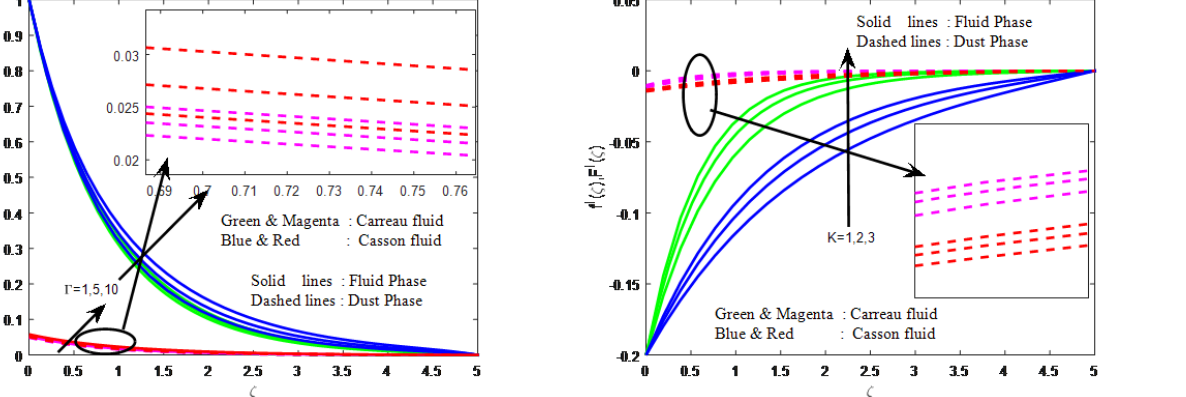
Fig. 8: Impact of Γ on temperature profiles.